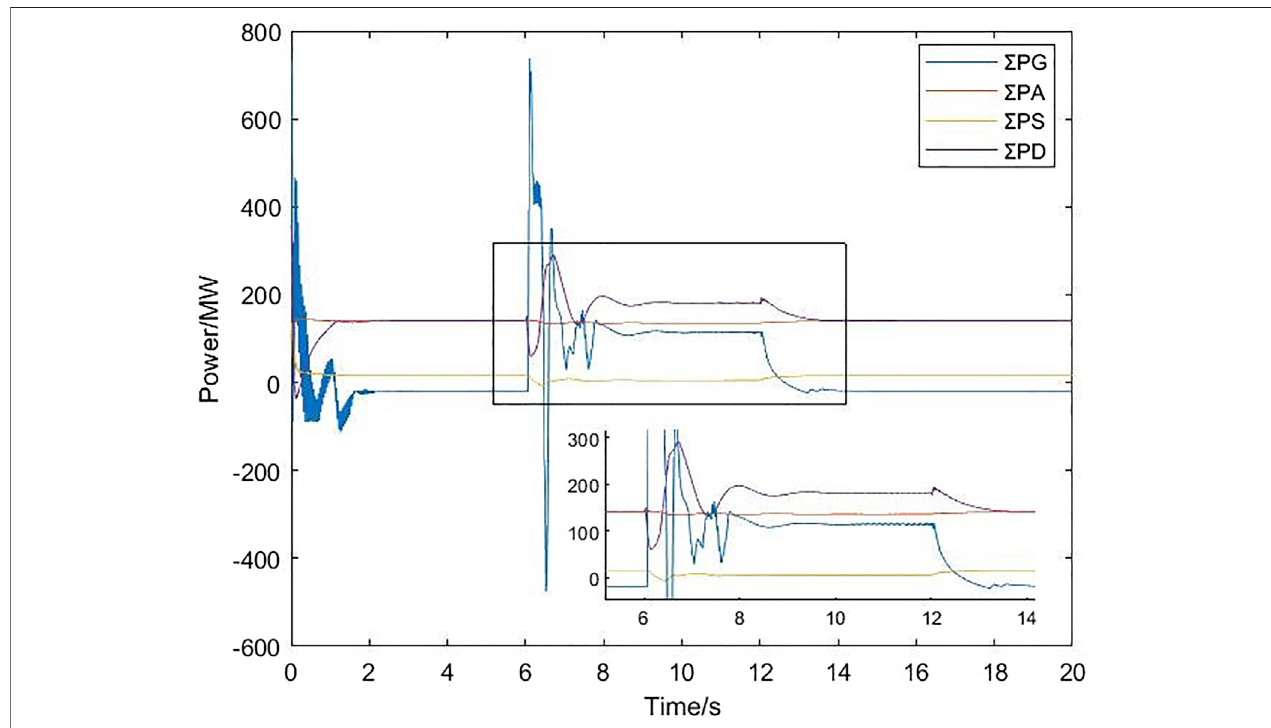
FIGURE 7 | Simulation results of consensus